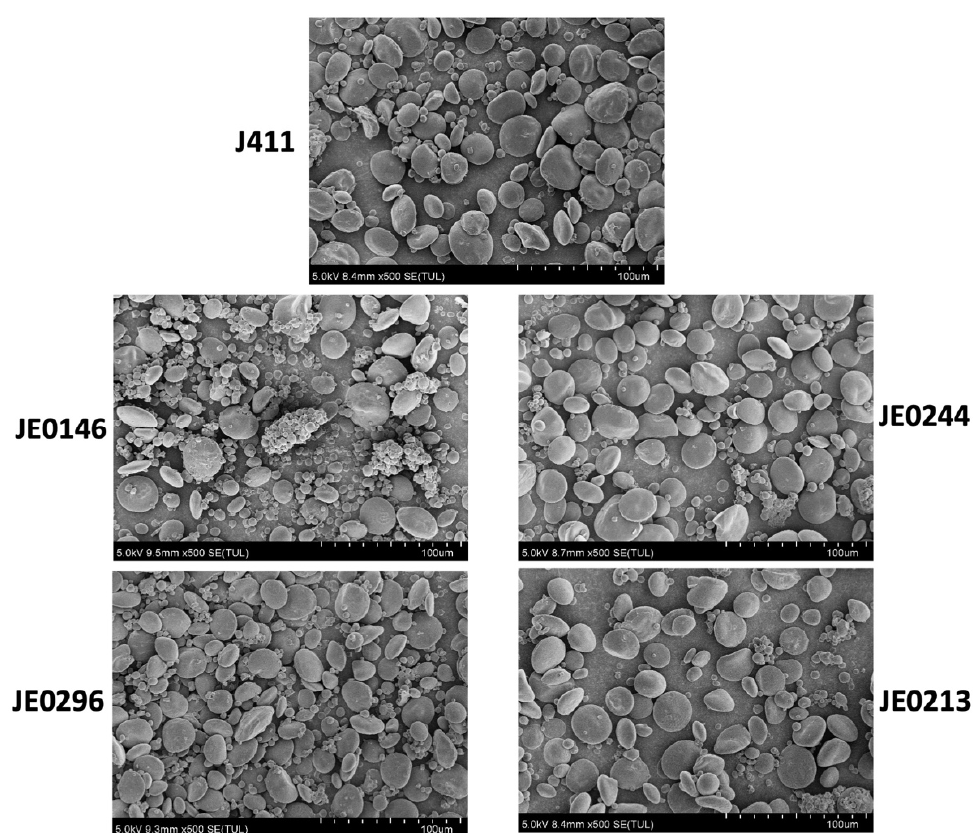
Figure 4. Comparison between the grain morphology of the high and low resistant starch mutants, and the WT (J411). JE0146 and JE0296 are the high resistant starch mutant lines; while JE0244 and JE0213 are the low resistant starch mutant lines.